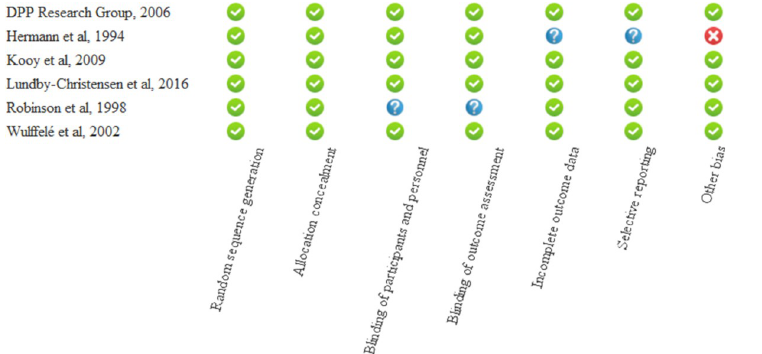
Fig 2. Summary assessment of risk of bias of the included studies.